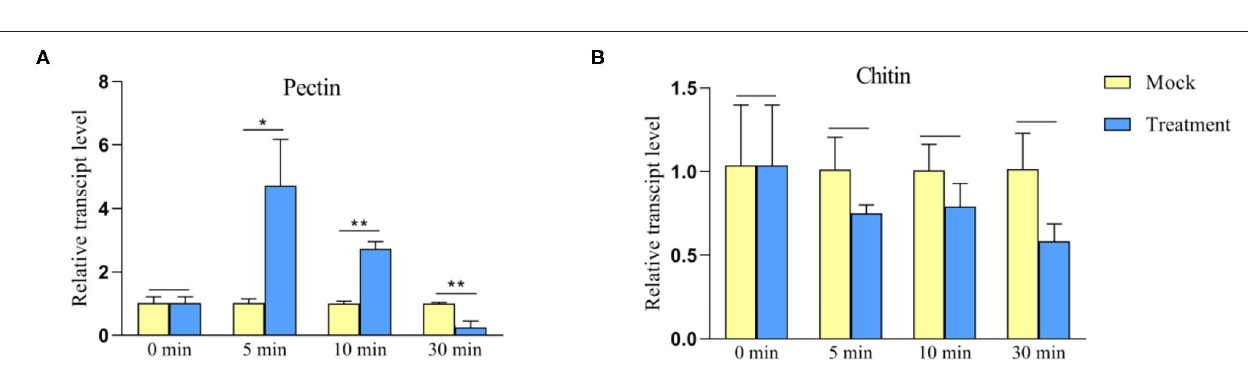
FIGURE 7 | Transcript patterns of defense-related genes in pMAS: GFP and pMAS: TaWAK-6D-GFP ectopic expression Nicotiana benthamiana leaves. (A) Ectopic expression of TaWAK-6D in N. benthamiana leaves. a pMAS: TaWAK-6D-GFP fusion construct and the control pMAS: GFP vectors were separately introduced into Agrobacterium and infiltrated into N. benthamiana leaves to transiently expressed for 48h. (B) The transcript level of defense-related genes in pMAS: TaWAK-6D-GFP and the pMAS: GFP (control) ectopic expression N. benthamiana leaves. Statistically significant differences between pMAS: TaWAK-6D-GFP and the pMAS: GFP (control) N. benthamiana leaves were determined based on three replications using a t -test (** P < 0.01). Bars indicate the SEs of the mean. NbActin was used as an internal control.